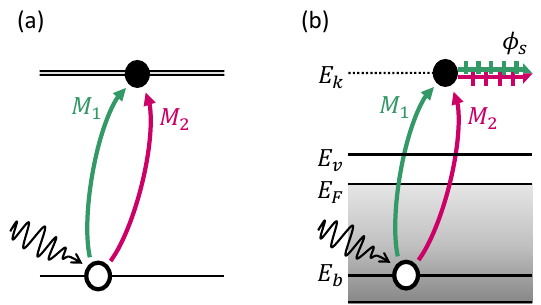
Figure 1: (a) Interference of matrix elements in atomic photoionization for the tran- sition (cid:96) → (cid:96) ± 1. (b) Two interfering transitions build up the photoemission final state wavefunction, and their phase shift will determine an angular resolved spin